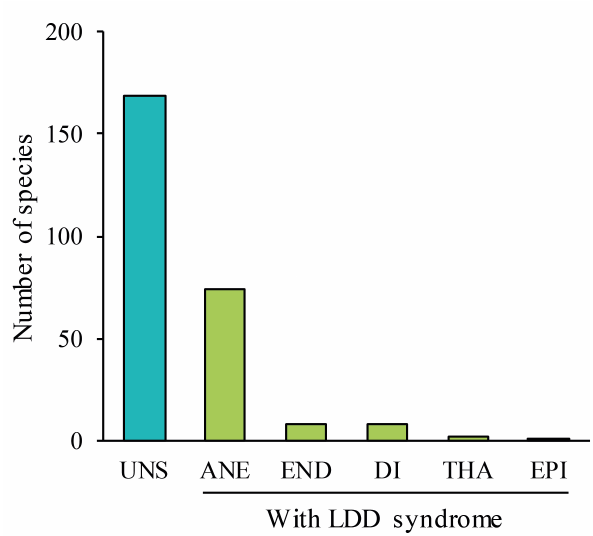
Figure 3. Percentage of threatened and non- threatened species with LDD syndromes (green) and unspecialized (UNS, blue) in the endemic lowland flora of the Canary Islands. χ 2 = 0.55, 1 df, p = 0.46. (Online version in color).